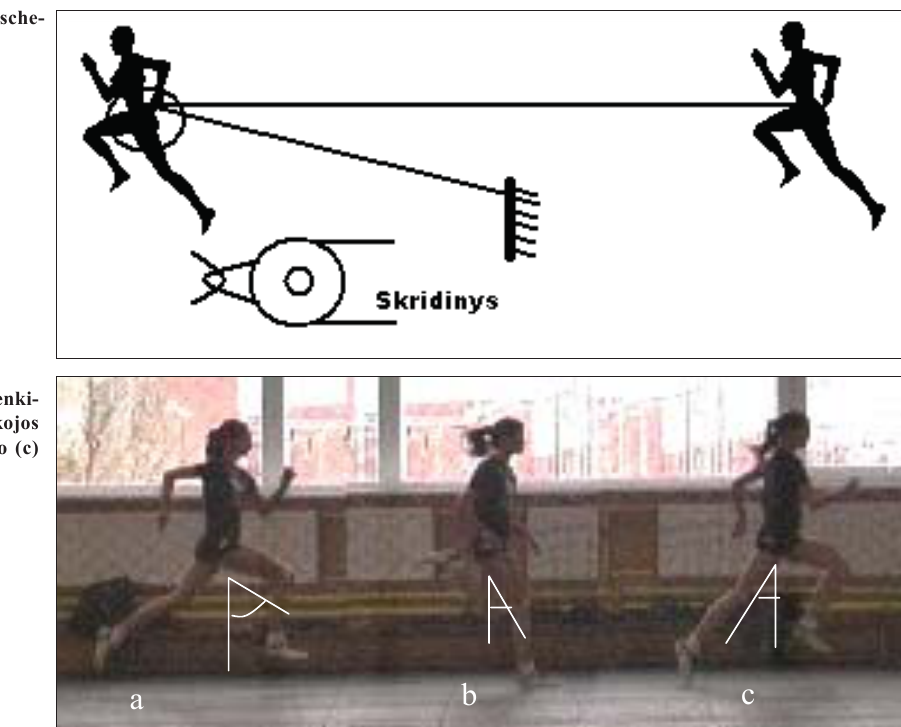
Vidutinis b ė gimo greitis buvo apskai č iuotas ( č ia L — b ė gimo ciklo pagal formul ę : V = L / t ciklo ilgis — atstumas nuo kair ė s p ė dos piršt ų atramos metu iki kitos atramos kaire koja p ė dos piršt ų ; — ciklo trukm ė — laiko intervalas nuo kair ė t ciklo